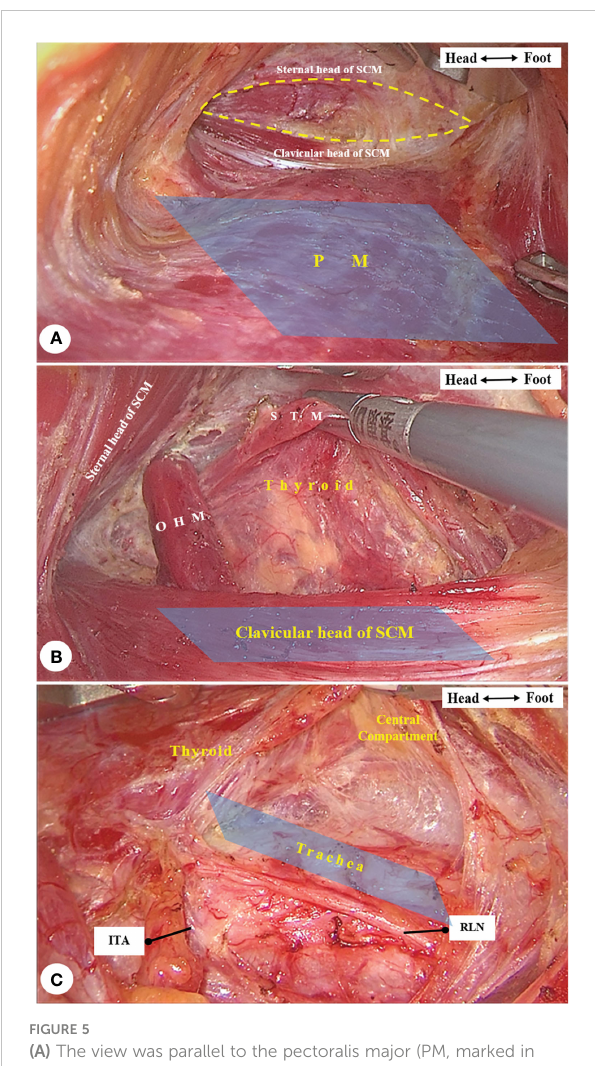
FIGURE 5 (A) The view was parallel to the pectoralis major (PM, marked in blue) while expanding the space (circled in dotted curve) between the two heads of sternocleidomastoid muscle (SCM). (B) The view was parallel to the clavicular head of SCM (marked in blue) when releasing the omohyoid muscle (OHM) and exposing the sternothyroid muscle (STM) and thyroid gland. (C) The view was parallel to the trachea (marked in blue) with the cephalic side slightly elevated for all following